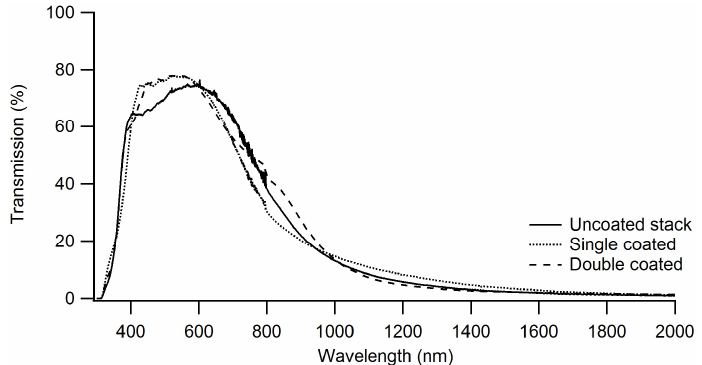
Figure 10. Transmission spectra of the uncoated stack and samples of single coated window film and double coated window film. The double coated window film is more reflective in the region between 400 nm and 600 nm than the single coated window film.